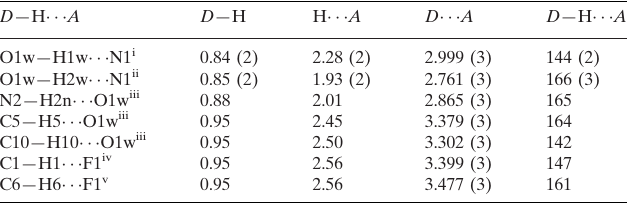
Hydrogen-bond geometry (A˚ , (cid:3)